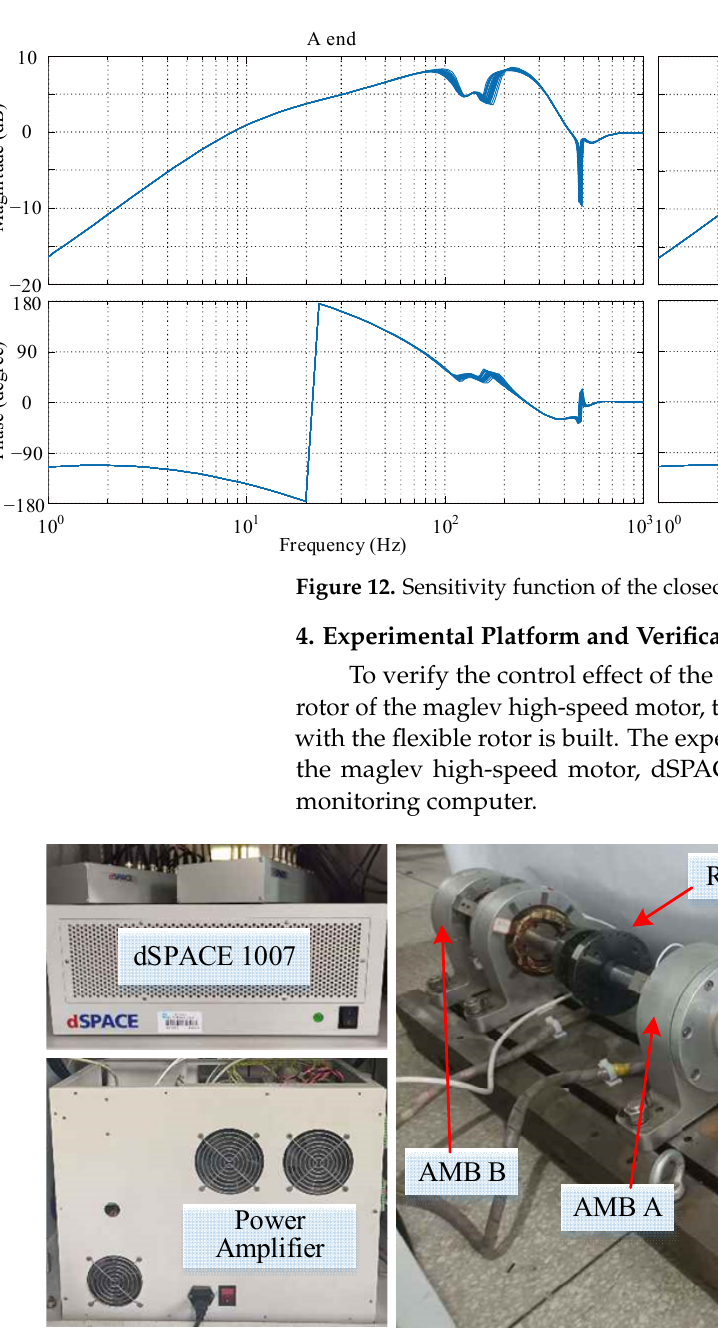
Figure 13. Maglev high-speed motor experimental platform with the flexible rotor. The DC bus voltage of the power amplifier is 70 V, and the switching frequency is 25 kHz. The measuring range of the eddy current displacement sensor is 1 mm, and the static accuracy is ± 0.5 µ m. The parameters of the experimental platform are in Table 1. After designing the µ -controller according to the previous process, the controller is discretized at a frequency of 20 kHz with bilinear transformation and then executed in the dSPACE 1007 rapid control